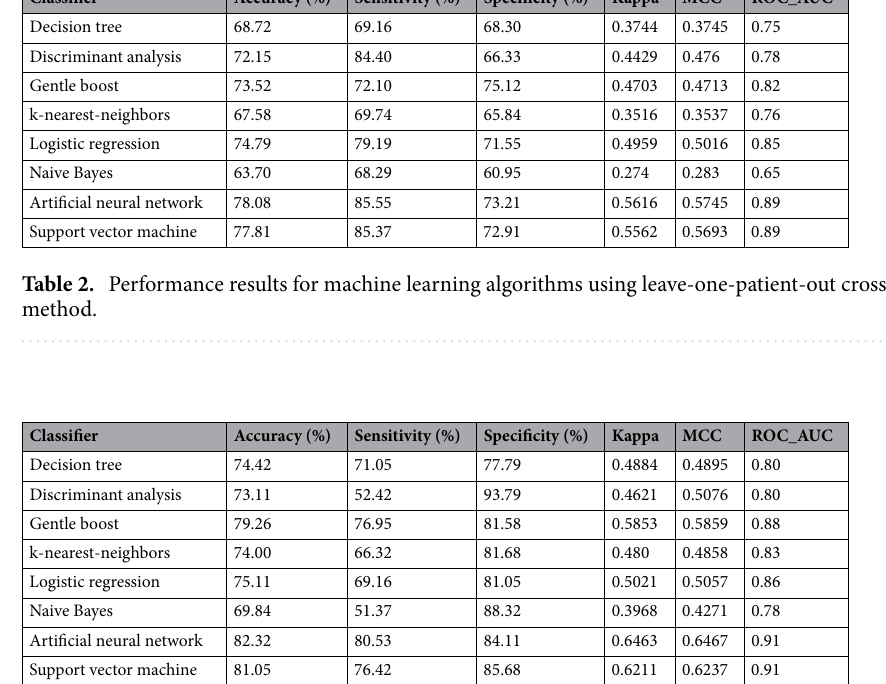
Table 3. Performance results for machine learning algorithms using k-fold cross validation